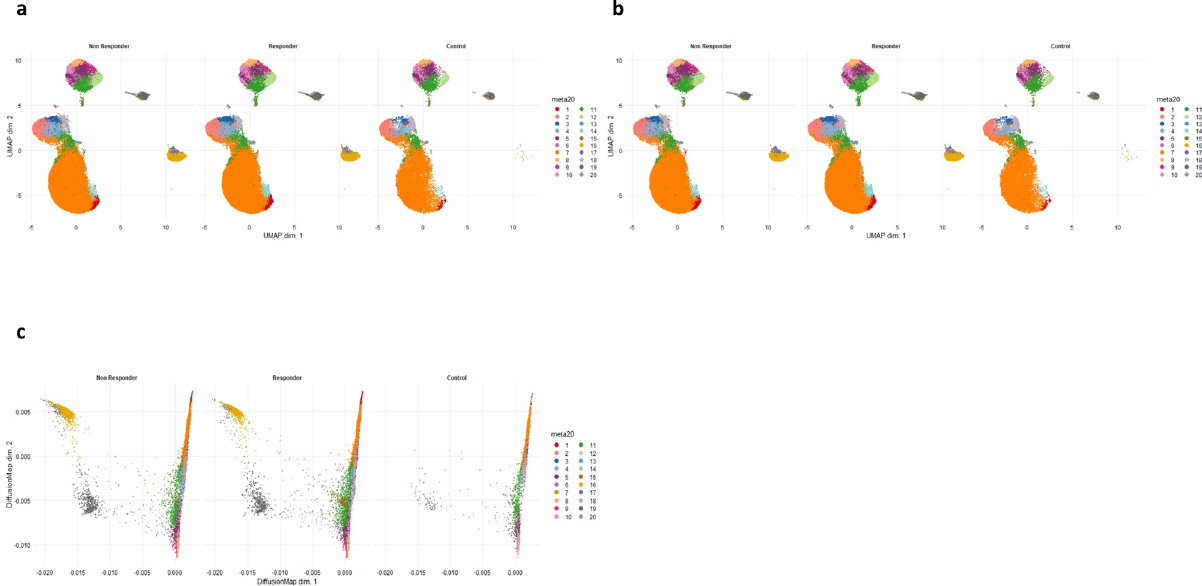
Fig. 7 Comparative dimensionality reduction plots show no major reciprocal de fi ciencies of toxicity-linked clusters in non-responders ( n = 46). a UMAP plots strati fi ed according to condition, “ responder ” , “ non-responder ” and “ healthy controls ” . There are no major visual differences in cluster abundance between responders and non-responders. This is also the case when speci fi cally looking at the toxicity-linked clusters. All samples are randomly downsampled to account for equally representative populations across samples. b Diffusion map strati fi ed according to condition, “ responder ” , “ non- responder ” and “ healthy controls ” . There are no major visual differences in cluster abundance between responders and non-responders. This is also the case when speci fi cally looking at the toxicity-linked clusters. All samples are randomly downsampled to account for equally representative populations across samples. c UMAP plots strati fi ed according to overall population IL-10 and PD-L1 expression and by condition. Expression is largely con fi ned to the suppressive B-cell clusters demarcated by the red arrows, however, there is no major difference in IL-10 expression between conditions, but there is higher expression of PD-L1 in non-responders. Both PDL1 + clusters (green box) were signi fi cantly more abundant in non-responders when analysed with differential abundance analysis ( P < 0.05, Benjamini – Hochberg